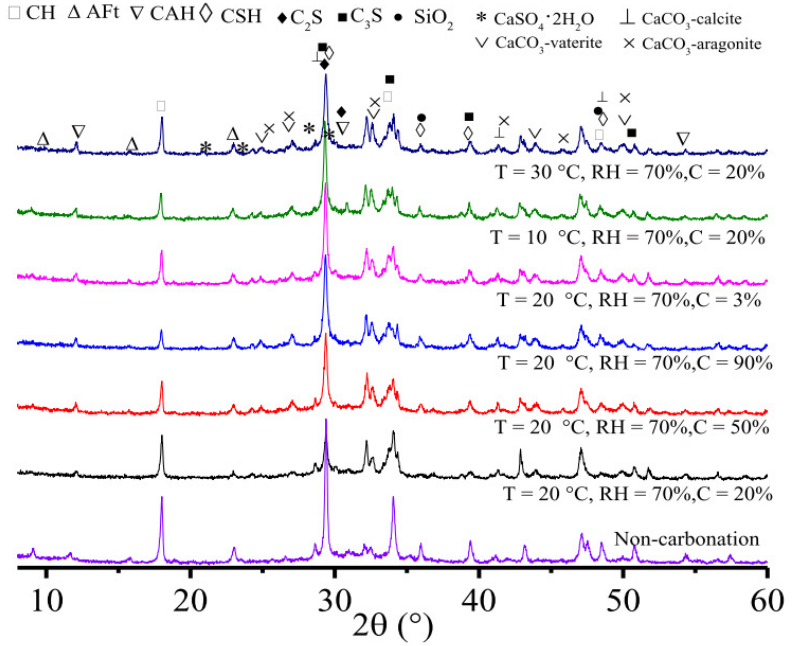
Figure 6. XRD data results of the phase composition at different curing conditions Figure 6. The variation of CH and CC content in non-carbonated (Ref) and carbonated (0.55) con- cretes. The dashed lines show the carbonation depth measured by indicator [26].